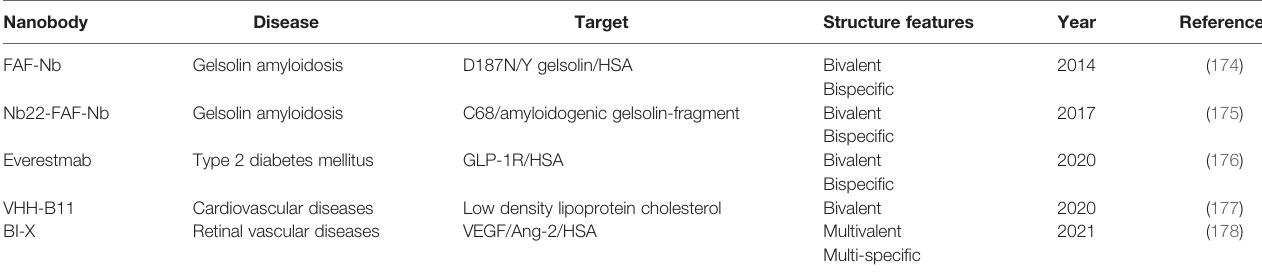
TABLE 5 | Other multivalent/bispeci fi c nanobodies with therapeutic